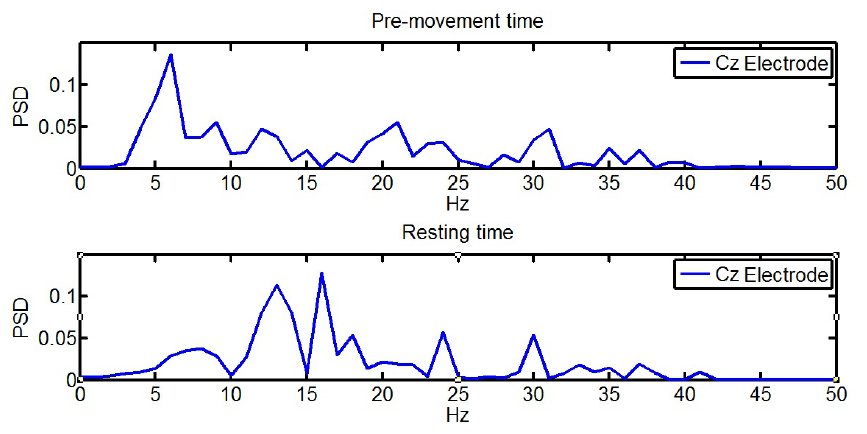
Figure 4. FFT performed on a single pre-movement ( top ) and resting ( bottom ) data of the electrode Cz. In this case, features in pre-movement are 0.1760, 0.2993, 0.0749 and in the sample of resting data are 0.1784, 0.5455 and 0.0722. In pre-movement data, there is lower activity in the 13–24 Hz band sum than in the resting